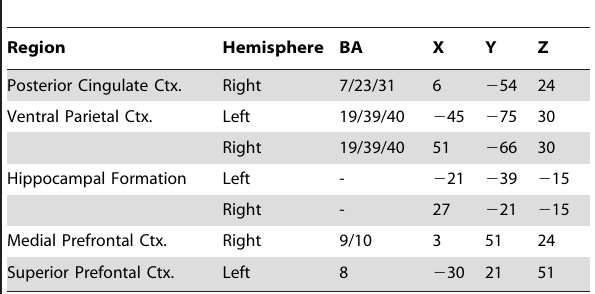
Table 4. Main effects and interactions during episodic